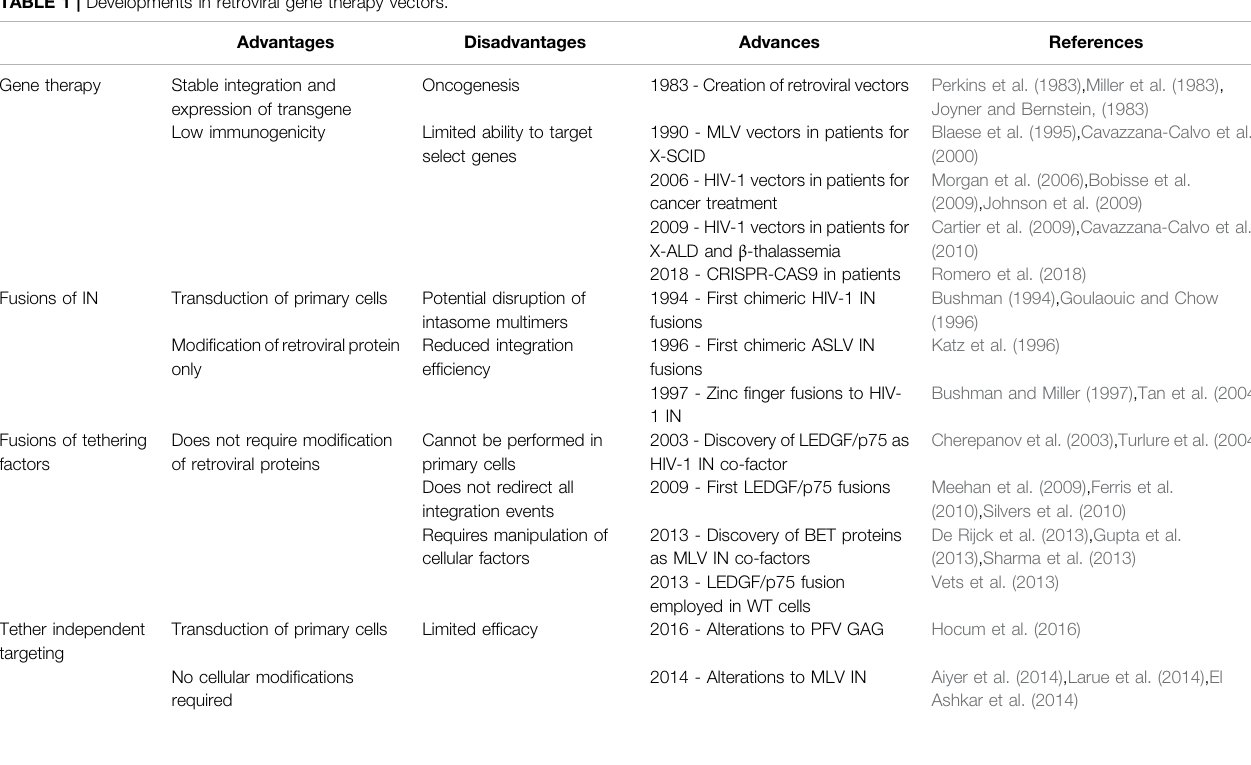
TABLE 1 | Developments in retroviral gene therapy